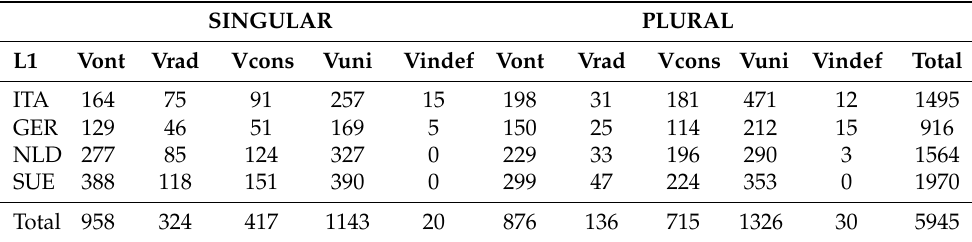
Table 3. Overview of the analyzed verb forms in third person singular and plural (tokens).